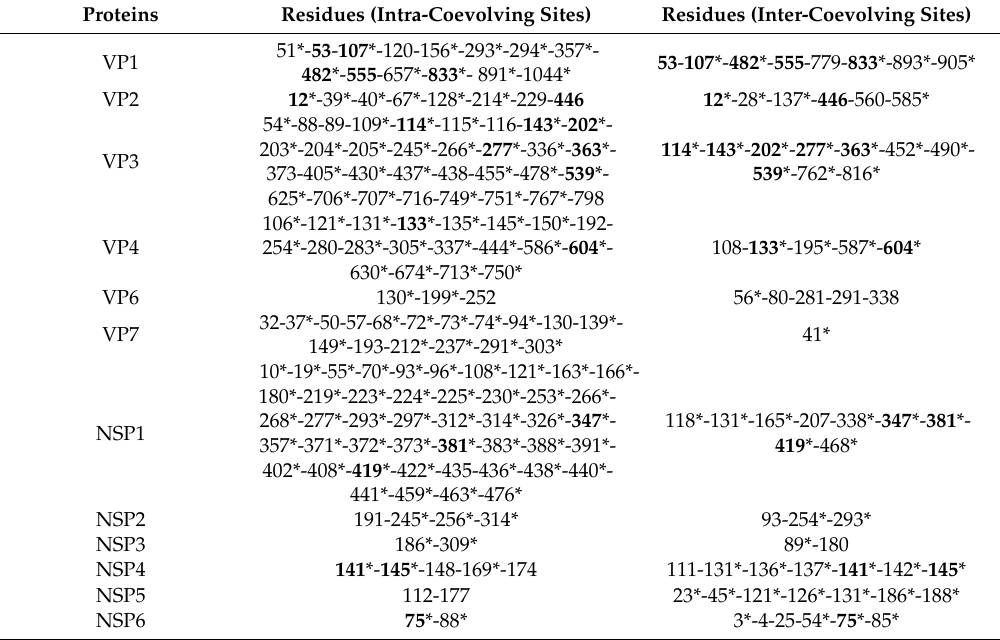
Table 1. Coevolutionary analysis of rotavirus proteins performed by Bayesian genetic